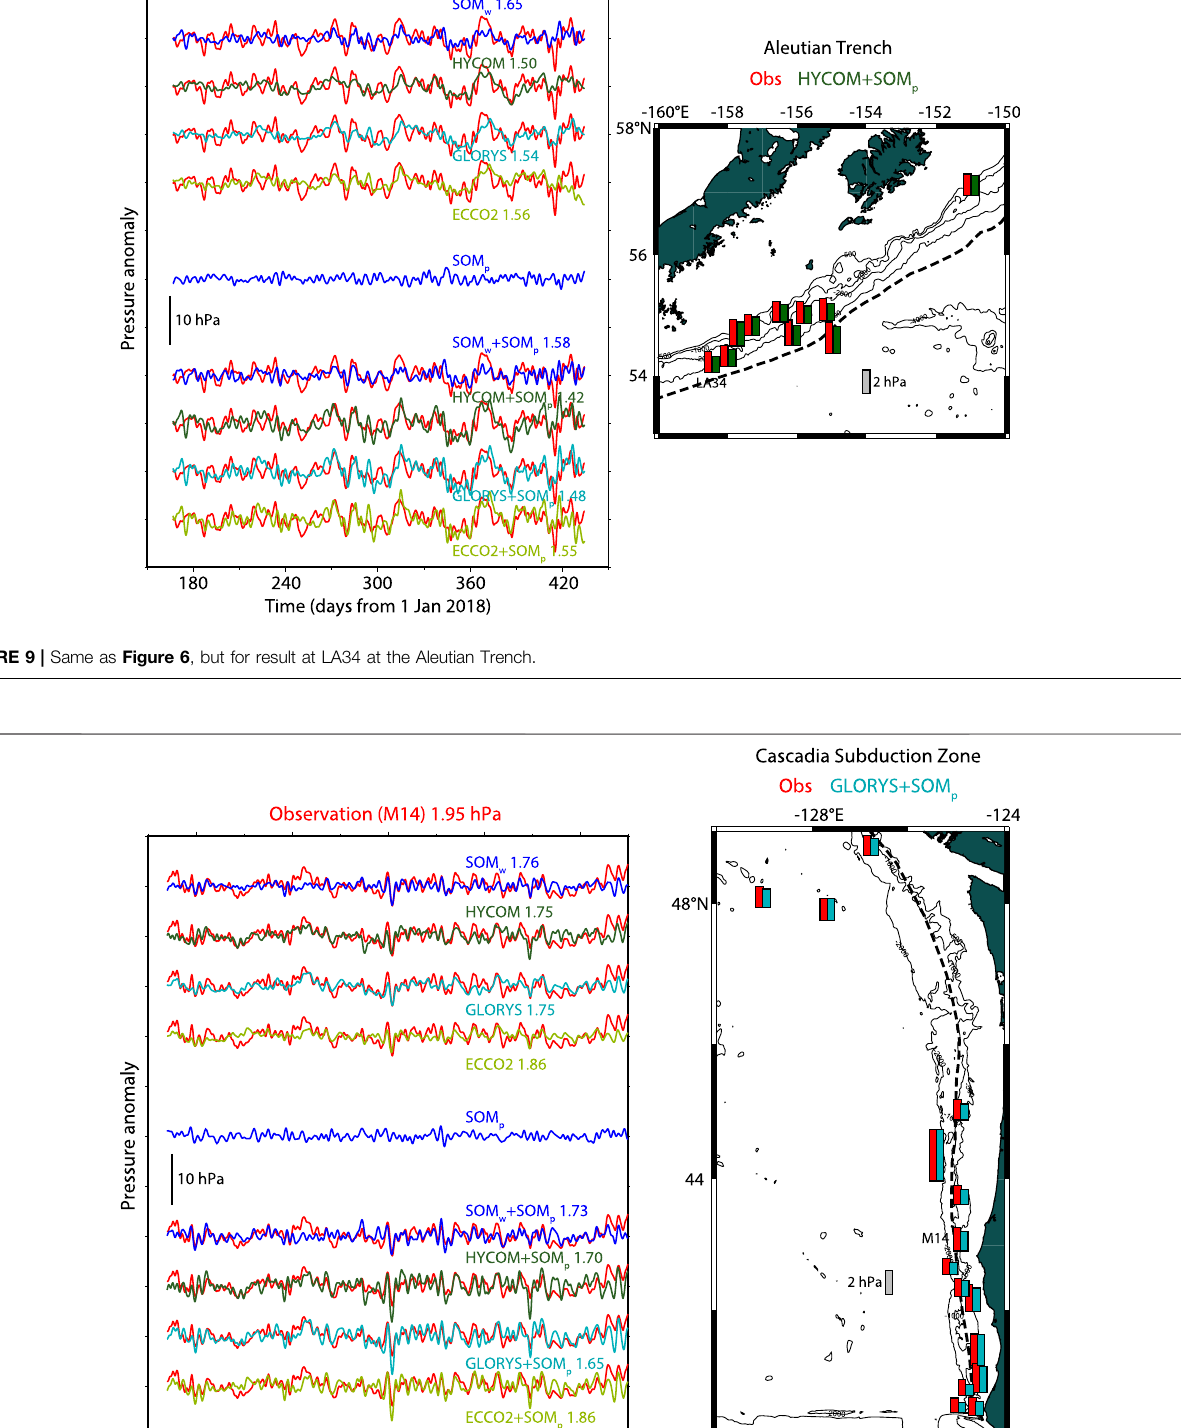
Frontiers in Earth Science |